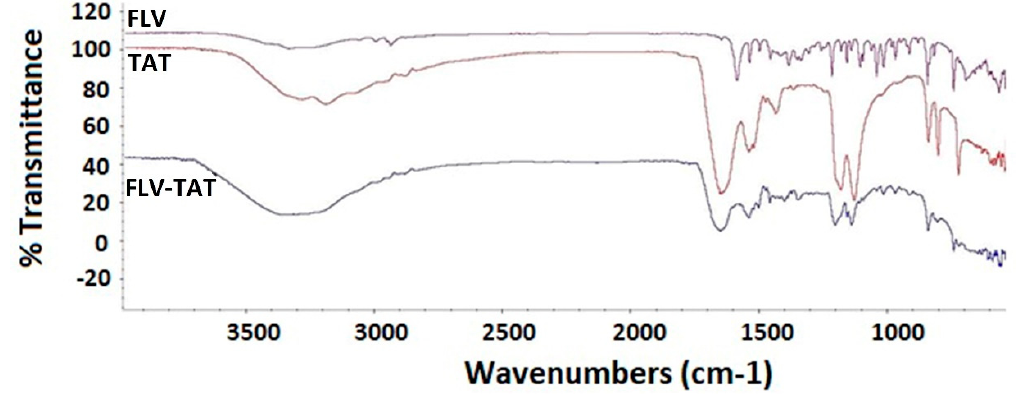
Figure 2. FLV, TAT, and FLV–TAT complex FTIR spectra.